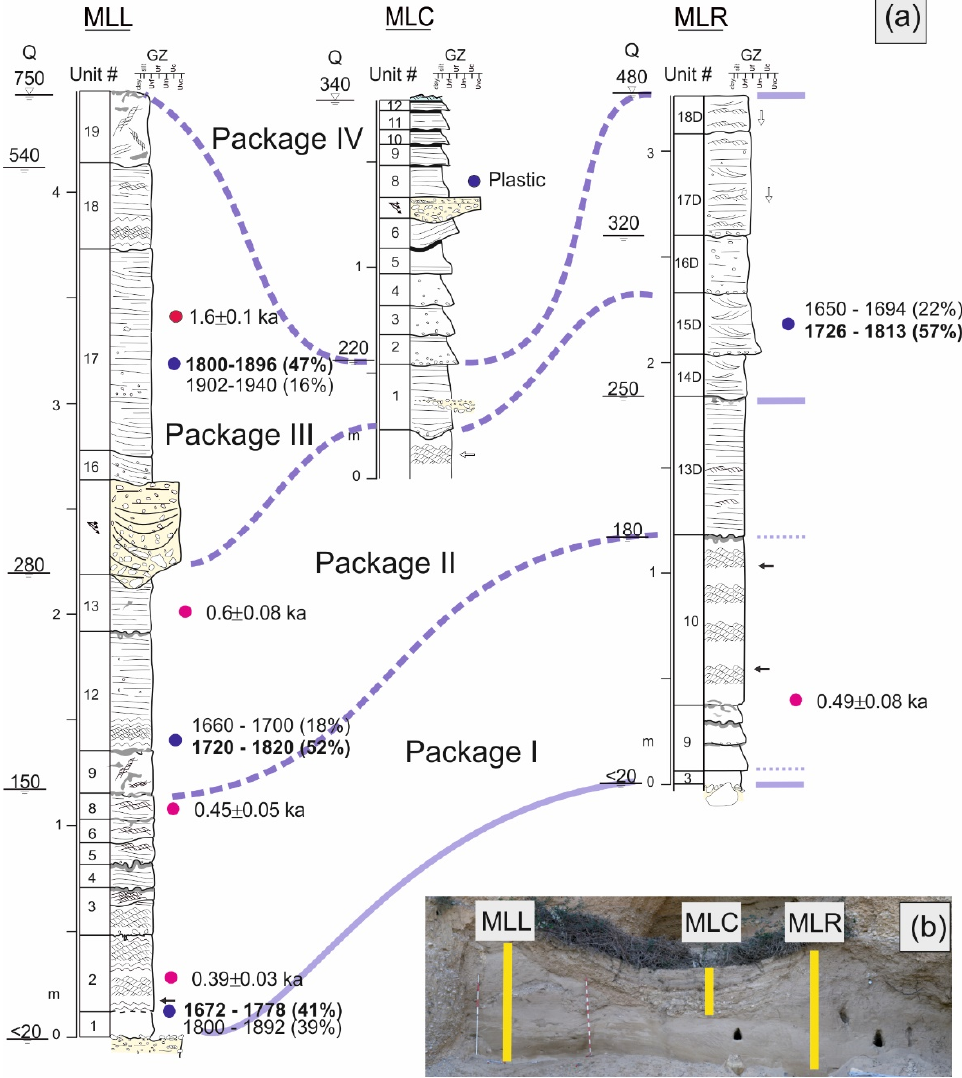
Figure 6. ( a ) Stratigraphic profiles MLL, MLC and MLR, and proposed correlations (dashed lines). Radiocarbon dates in calibrated years (CE) and luminescence dating in years before 2013. ( b ) The picture (same as Figure 5) shows the profile location. Legend in Figure